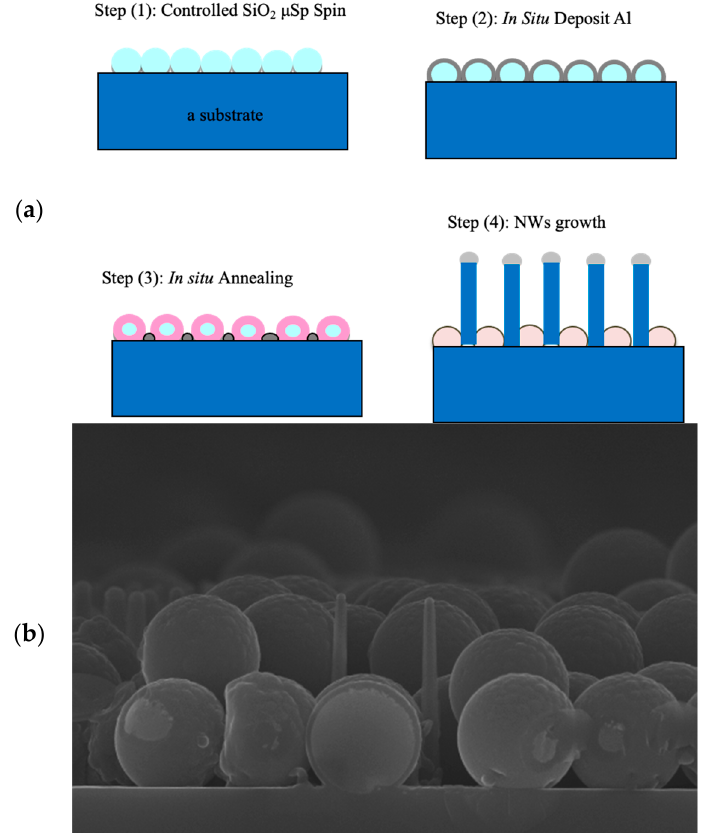
Figure 2. ( a ) A schematic representation showing that microspheres (MS) of silica were used for templating in four main steps, along with the side view SEM micrograph of grown Si-NWs between the MS ( b ). A thin unseeded planar Si layer forms on the surface of the oxidized Al on the outer surface of microspheres (just as for the standard lithography case). The gaps between microspheres could be controlled by varying the BOE time (scale bar is 500 nm).